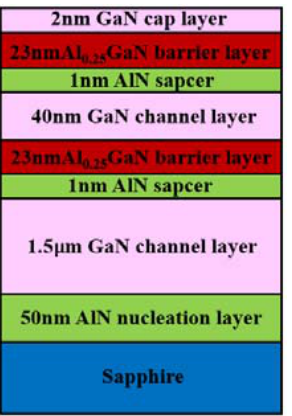
Figure 3. Diagram of the double channel epitaxial layer.